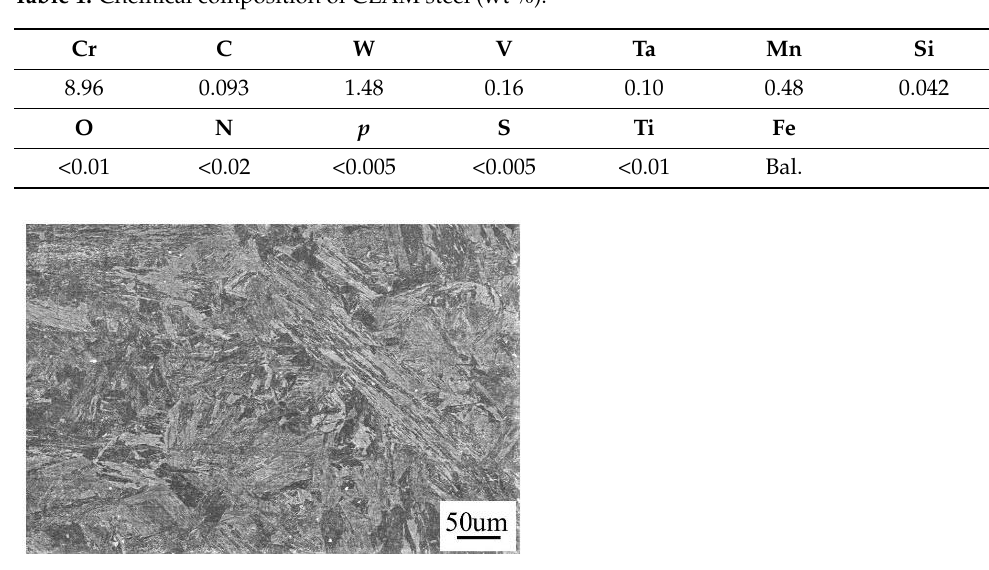
Figure 3. Microstructure of CLAM showing tempered martensite.